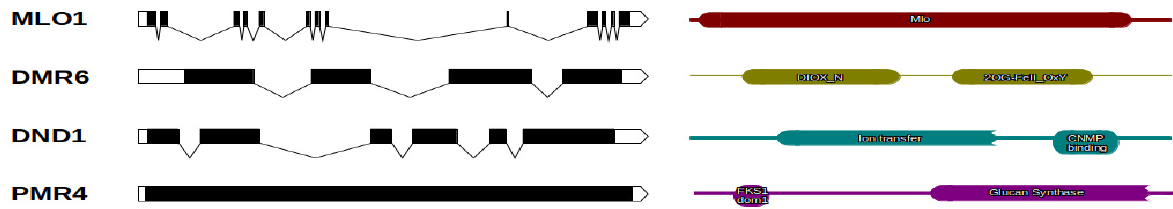
Figure 1. Chestnut S-genes and their protein structures. The graphical representations of gene exon/intron structures were generated using the http://wormweb.org/exonintron tool (accessed on 31 March 2021) and are shown in the left panel. The exons are indicated with black boxes, whereas introns are shown with lines. In the right panel, the protein structural domains are displayed. Table 1. S-genes detected in the C. mollissima v1.1 genome and protein domain annotations.